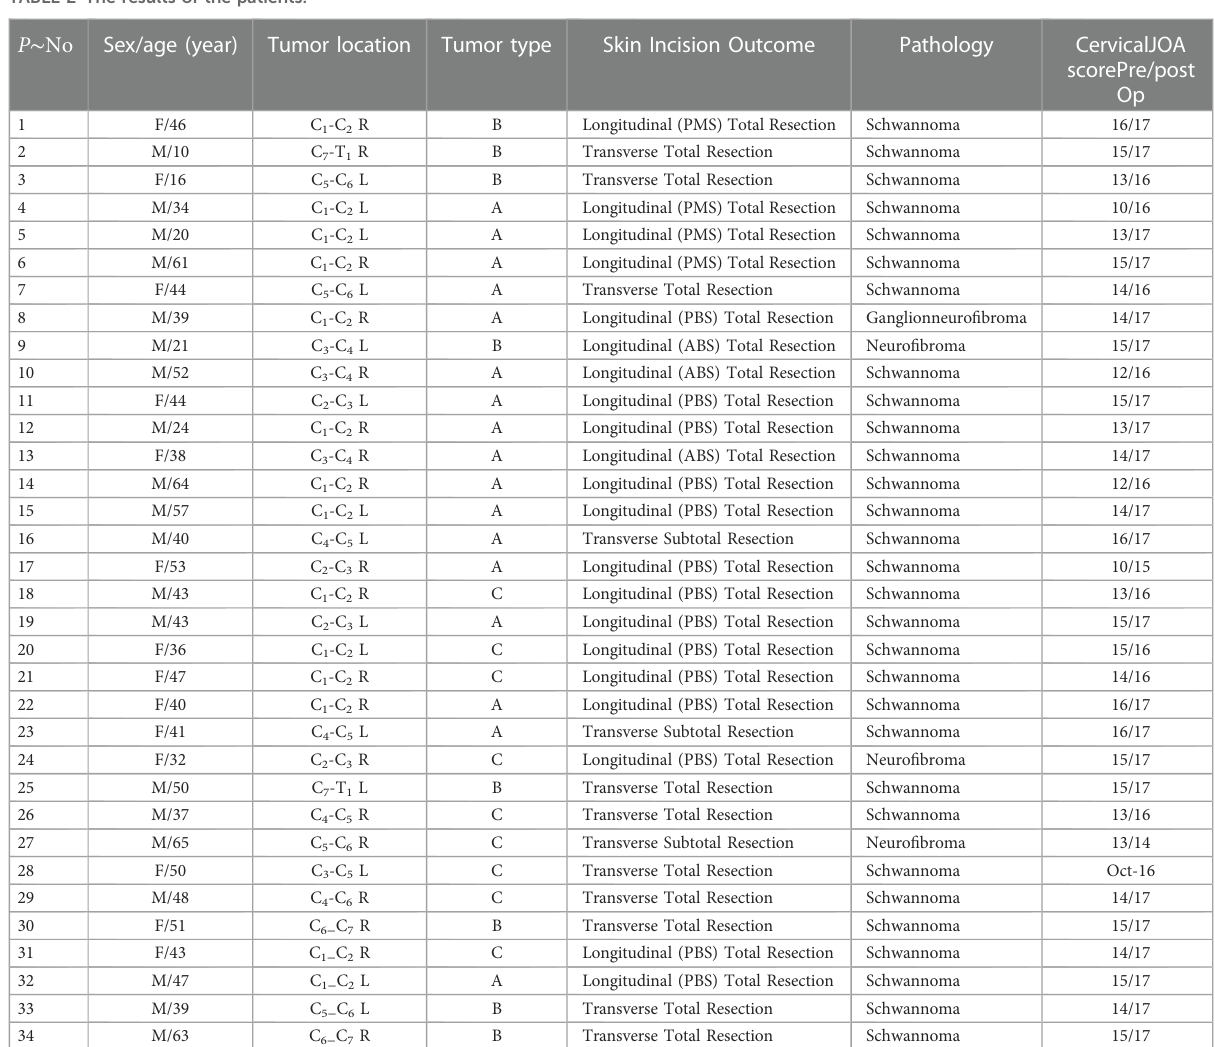
TABLE 2 The results of the